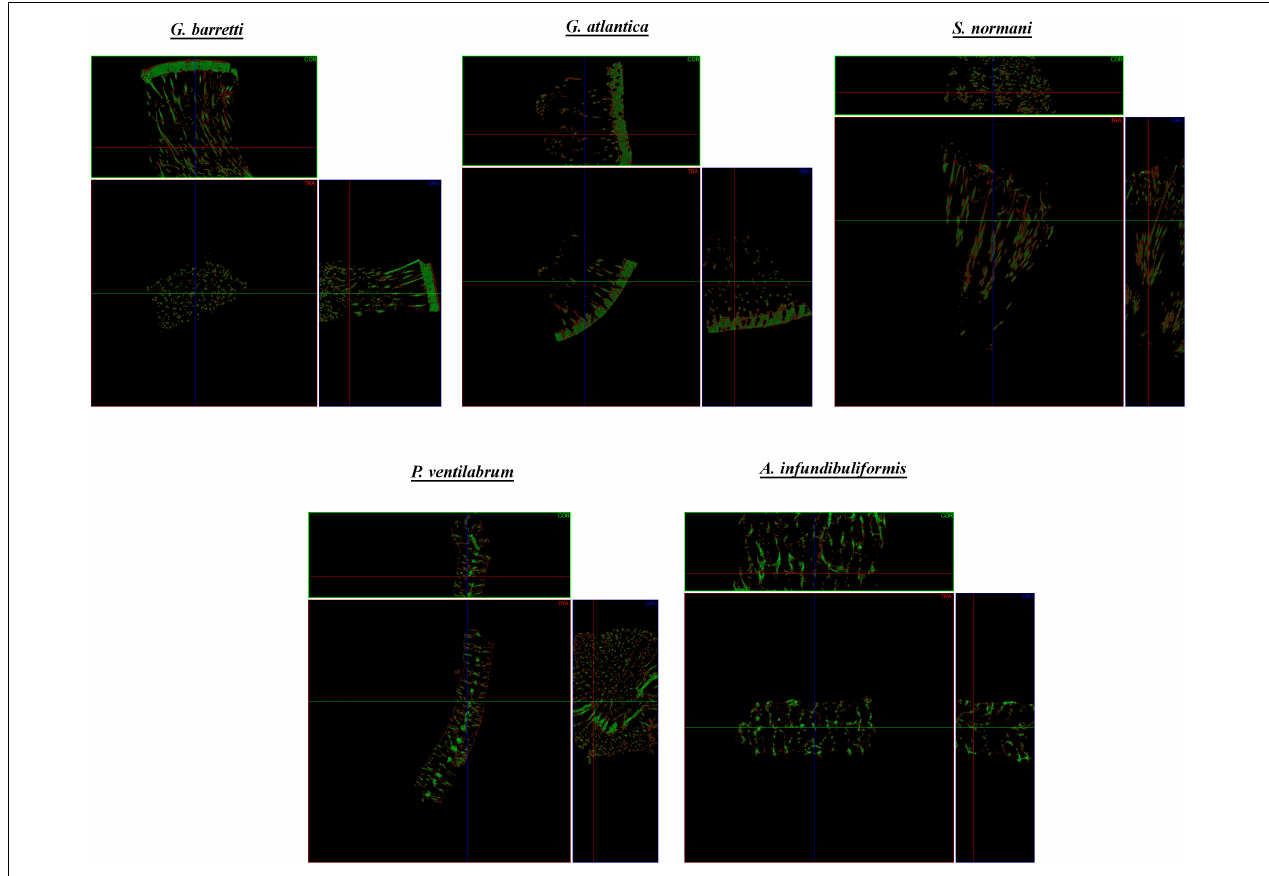
FIGURE 7 | Micro-CT representative coronal (COR), transverse (TRA) and sagittal (SAG) cross-sections of the skeletal of composition of the North Atlantic marine sponges. Each cross-section shows the sponge skeleton composition with the visualization of the organic matter (red) and inorganic matter